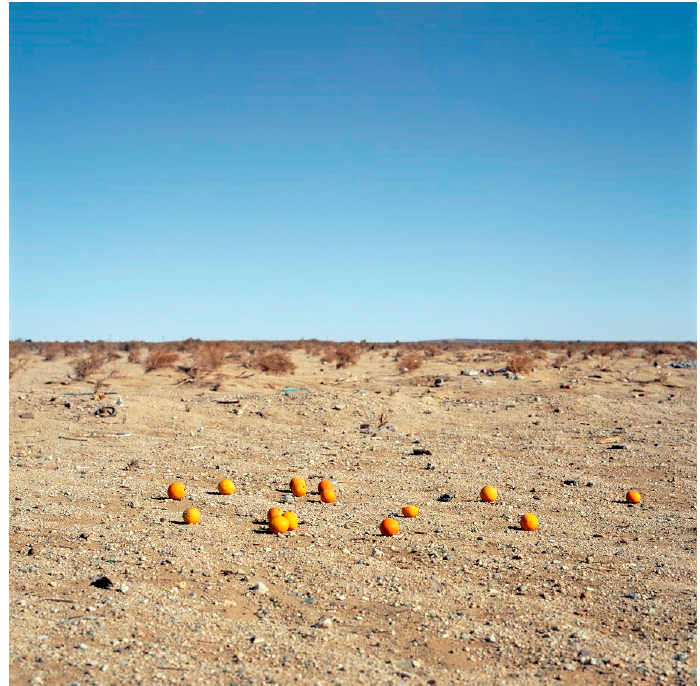
Figure 30. Anthony Hernandez, Discarded #9 (2013), © Anthony Hernandez.